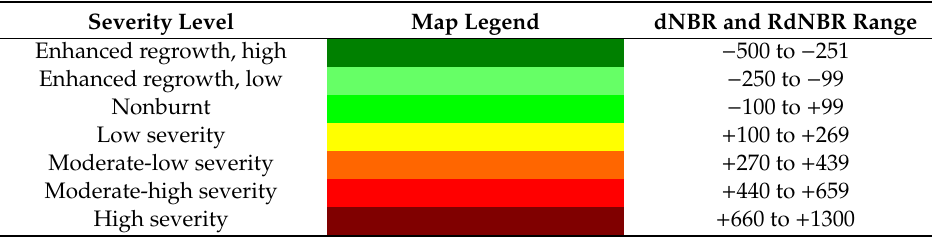
Table 2. Severity levels and dNBR × 10 3 and RdNBR × 10 3